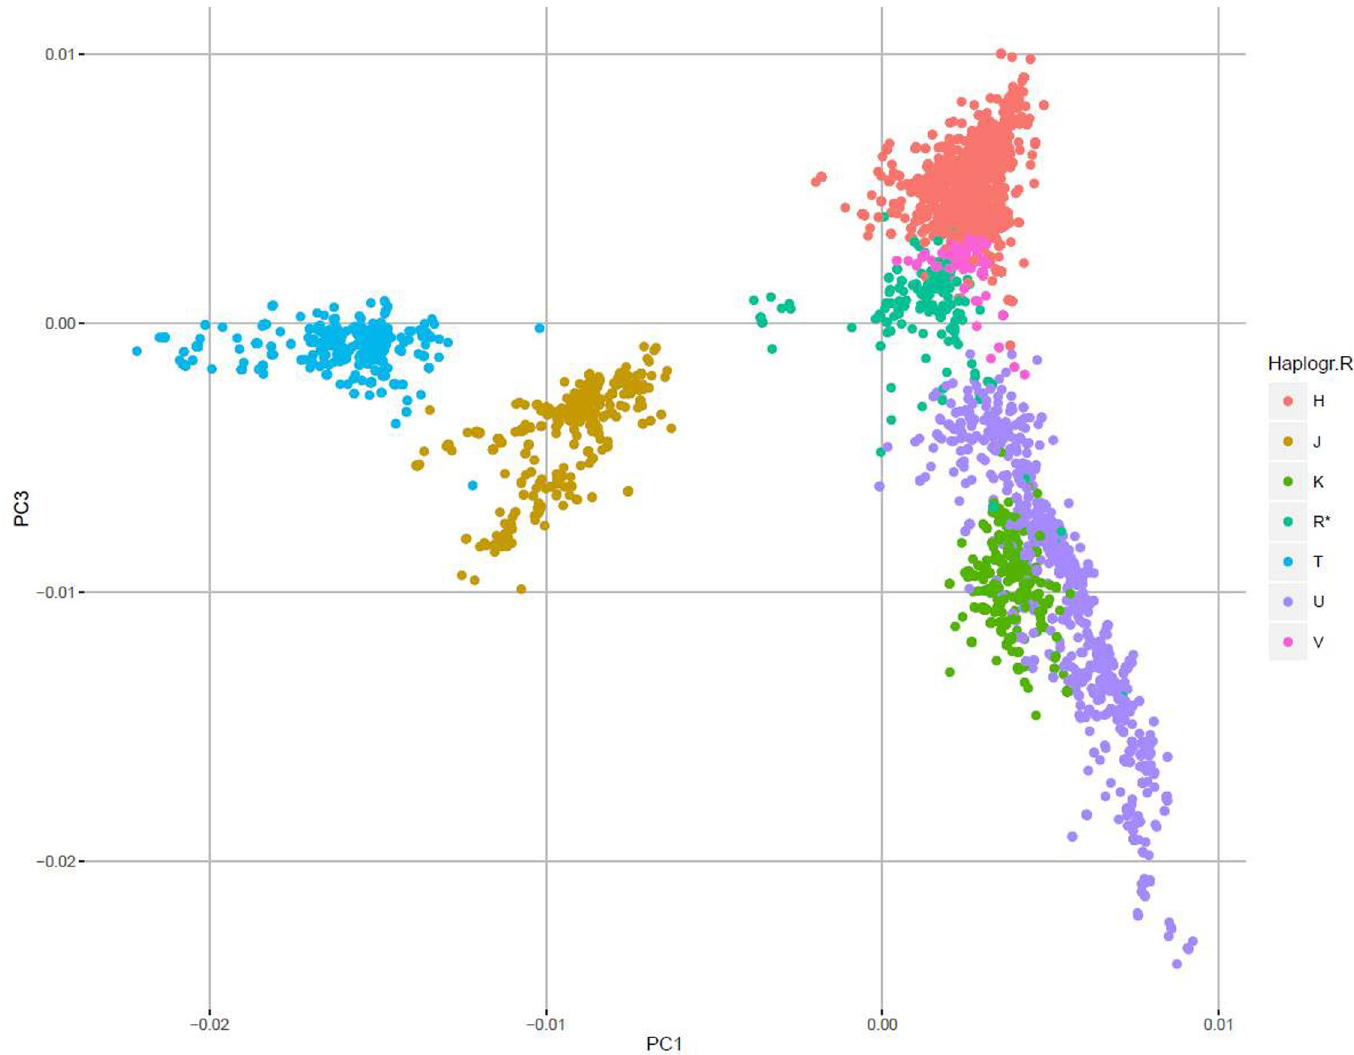
Fig 4. PCA of the macro-haplogroup R (the major European haplogroups). PC1: First principal component. PC3: Third principal component. (Table 5). In the Capital Region, the L hgs have a frequency of 1.3%, compared with 0.4–0.6% in the other regions and the M hgs have a frequency of 2.6% in the Capital region compared to 1.0–1.6% in the other regions. As the L and M hgs are rare in the European population and very frequent in African and Asian populations, the noted difference probably reflects a higher pro- portion and preferential localization of non-ethnic Danes in the Capital region. A similar spatial difference was apparent when the hg distributions of persons from the Danish metropolitan areas, comprising the major cities, Copenhagen, Aarhus, Odense and Aalborg, were compared with the distributions in the remaining rural areas (S4 Table). In the metropolitan areas, the combined frequency of L and M hgs was 4.4% as compared to 1.9% in the rural areas. Temporal distribution of mtDNA haplogroups The frequency of the major hgs H, J, T, K, V did not change significantly from year to year in the period from 1981 to 2005 (Results not shown).